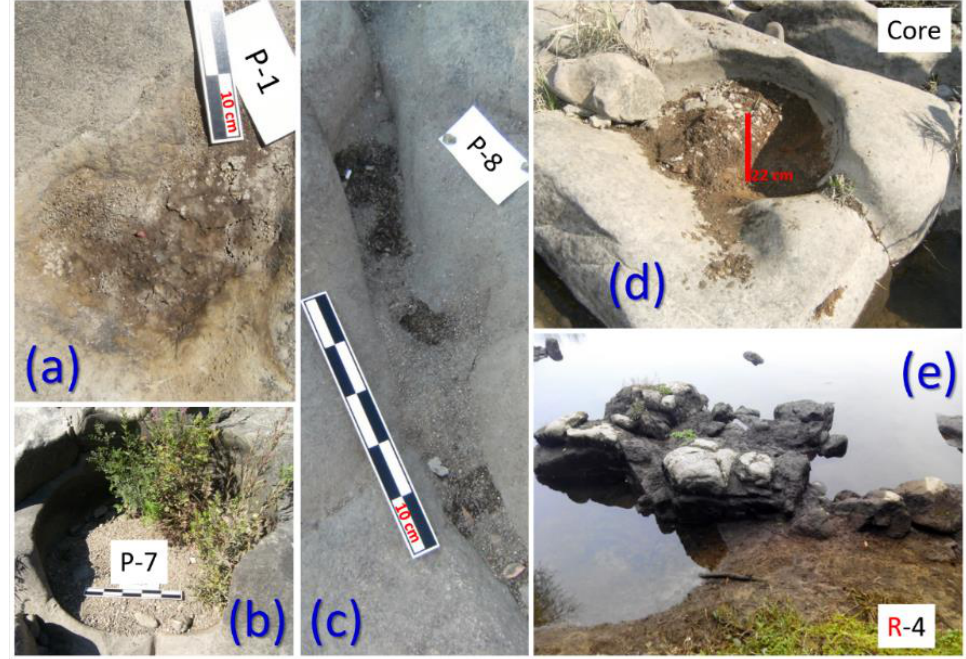
Figure 2. Examples of the sampled sediments, ( a – c ) correspond to surface sediments trapped by rock cavities (P), ( d ) is the sediment core (C) in the moment of sampling, and ( e ) corresponds to untrapped fluvial sediments (R).